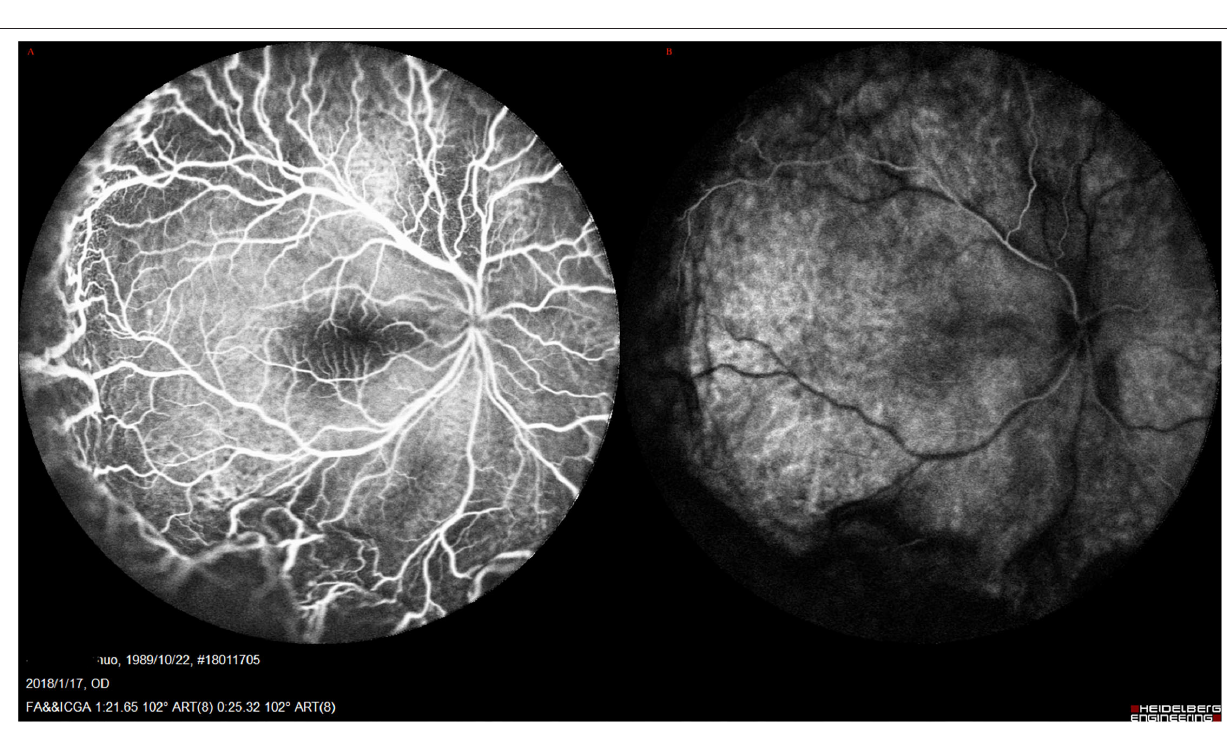
papilledema ( Figure 5 ). FA/ICGA findings showed diffuse patchy hyperfluorescence and leopard-spot signs, which were almost similar to those observed in type 1, without dye leakage in any eye ( Figures 6A,B ). UBM showed the presence of a ciliochoroidal